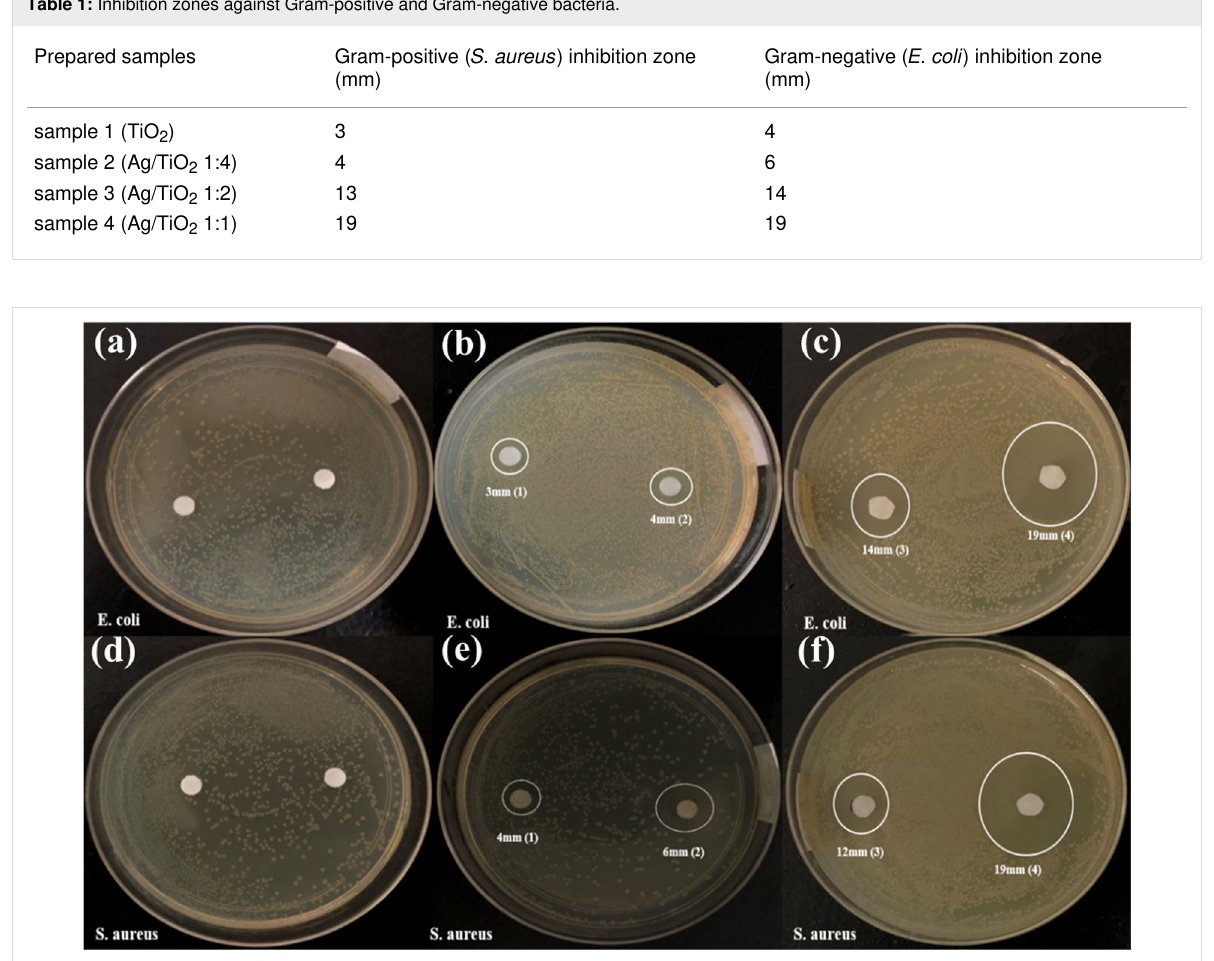
Figure 5: Antibacterial activity of the TiO 2 and Ag–TiO 2 nanocomposites against Gram-negative (a, b, c) and gram-positive (d, e, f) bacteria.